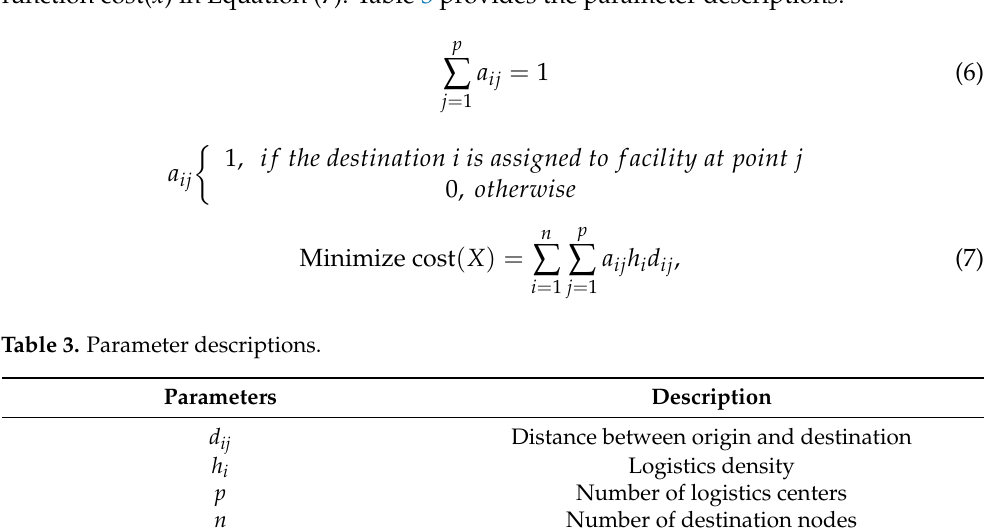
Table 4. Mathematical Models.